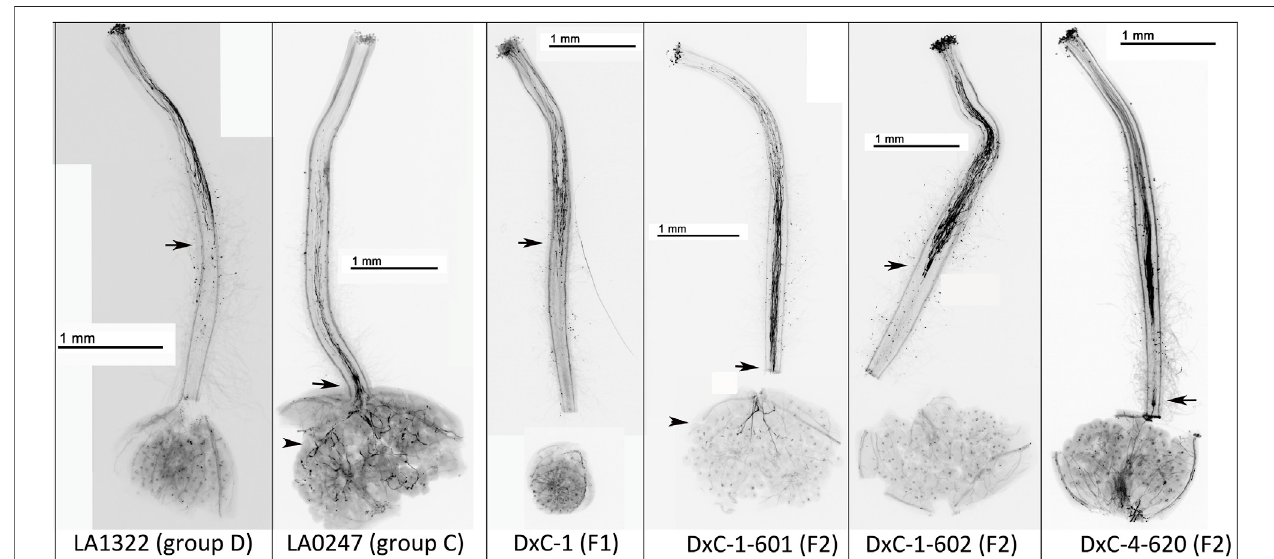
FIGURE3| IRBsin S.neorickii geographicgroupsDandC,F 1 andF 2 plants.RepresentativeimagesofcrossesintheF2plantswithpollenfromred-fruitedspecies ( S. lycopersicum or S. pimpinellifolium ). Plants used as the female in crosses are listed in the fi gures. Arrow indicates the point at which the majority of rejected pollen tubes stop growing and arrowhead indicates pollen tubes in the